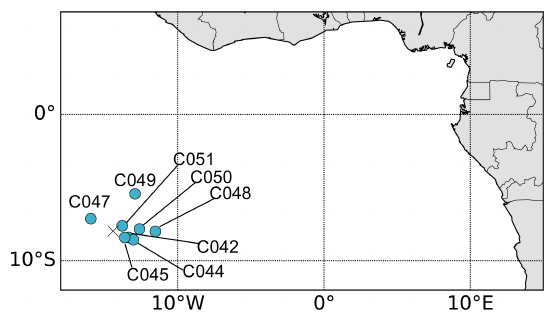
Figure 5. Map showing the geographical location of the dropsonde observations used in Sect. 3. The cross corresponds to Ascension